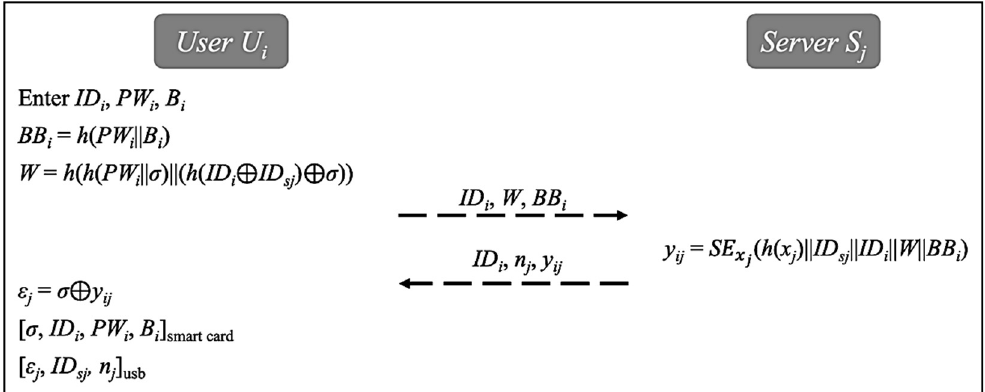
Figure 3. Registration phase.